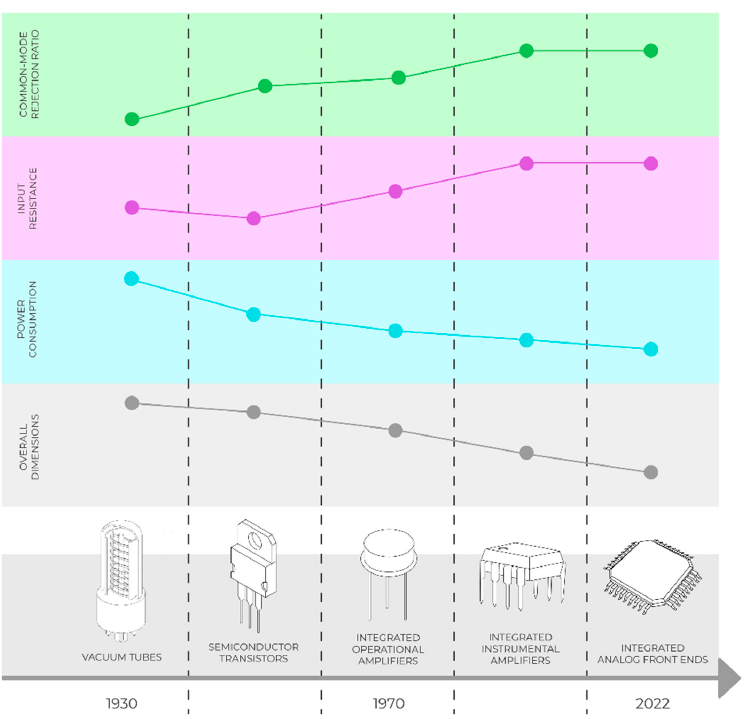
Figure 2. Trends in some technical parameters of bioamplifiers over the last 90 years due to the application of new element base, circuit designs and microelectronic technologies.